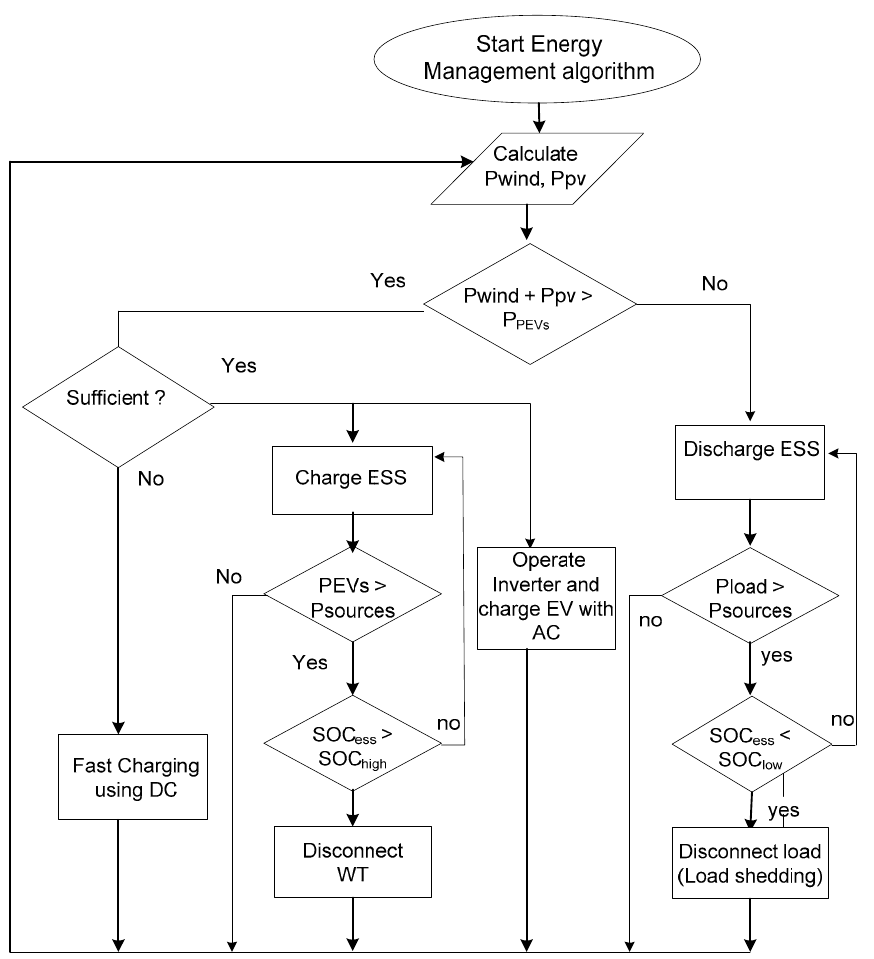
Figure 8. Flow chart of energy management control for the PV/wind/storage system.